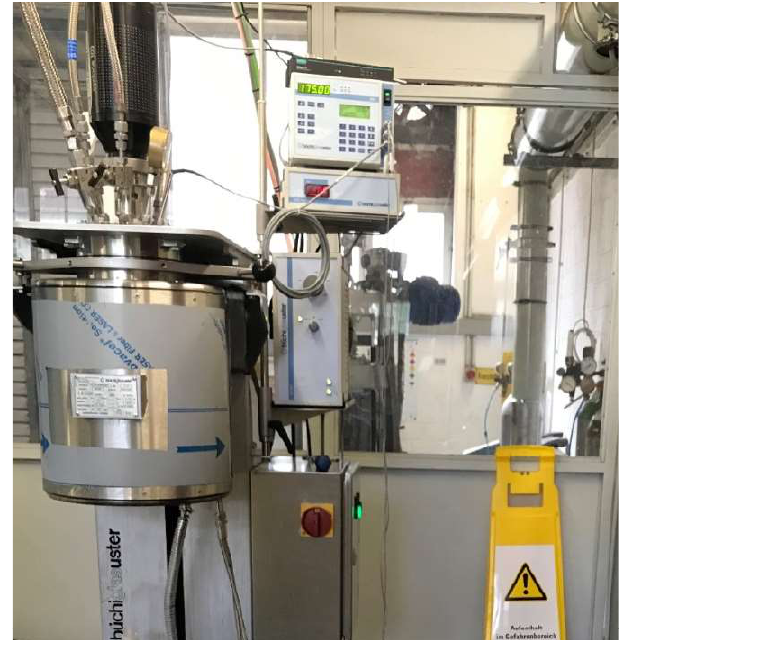
Figure 2 – Autoclave for the carbonation process Рис. 2 – Автоклав для процесса